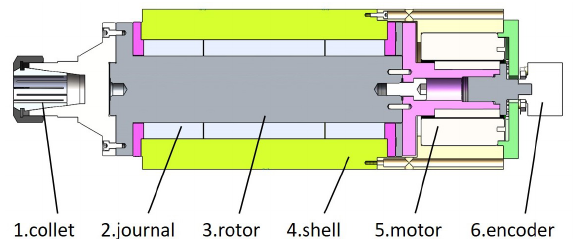
Figure 1. Aerostatic motorized spindle.